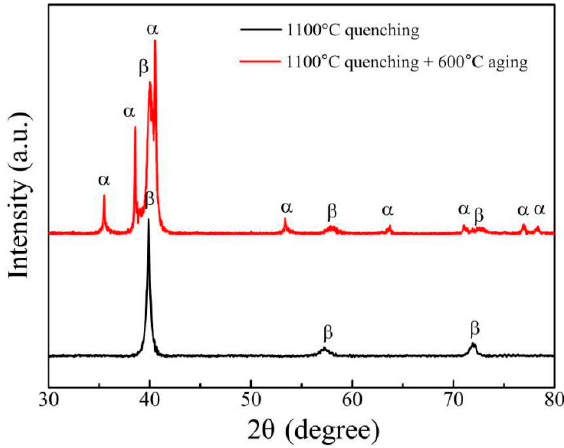
Figure 7 . XRD patterns of the quenched and aged Ti ‐ 6Al ‐ 10.9Cr alloy.